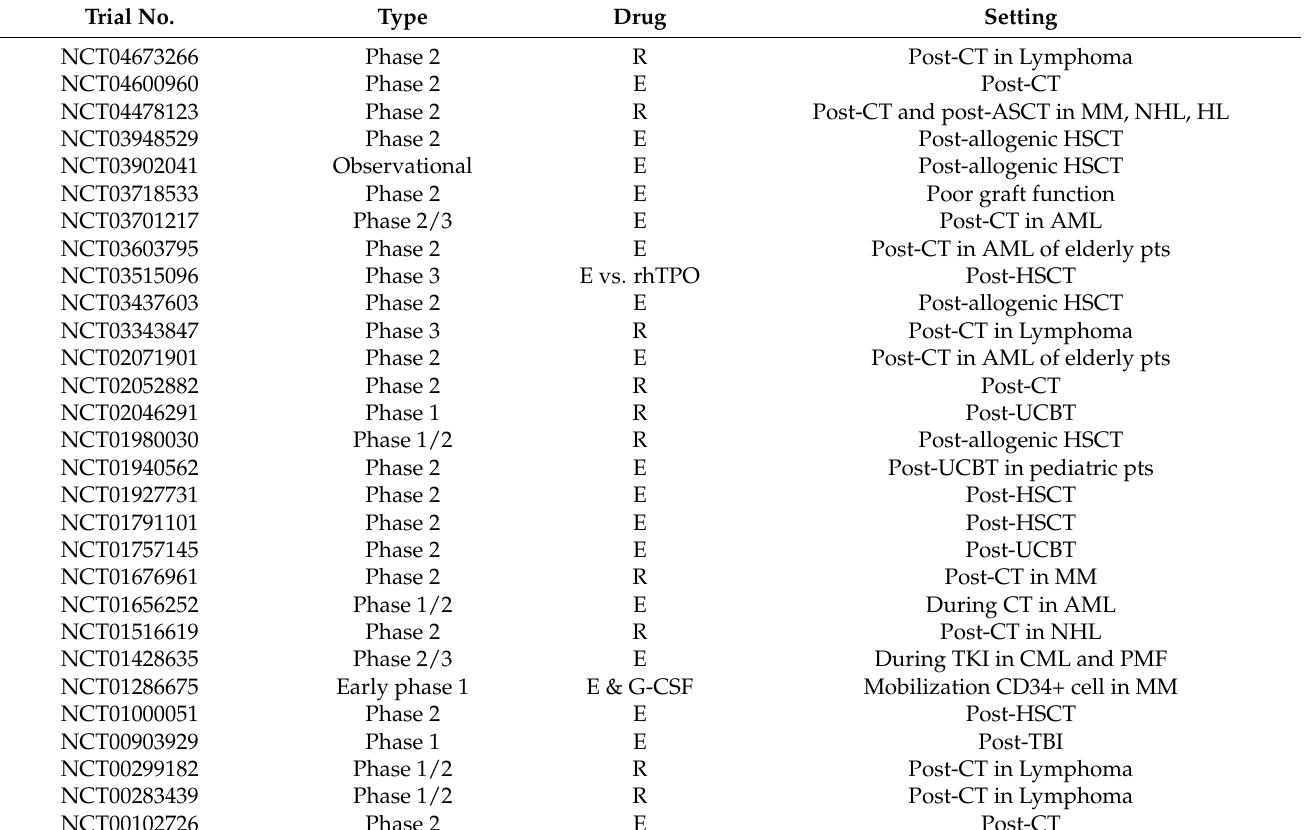
Table 4. Registered trials on ClinicalTrials.gov (accessed on 22 January 2022). Trial